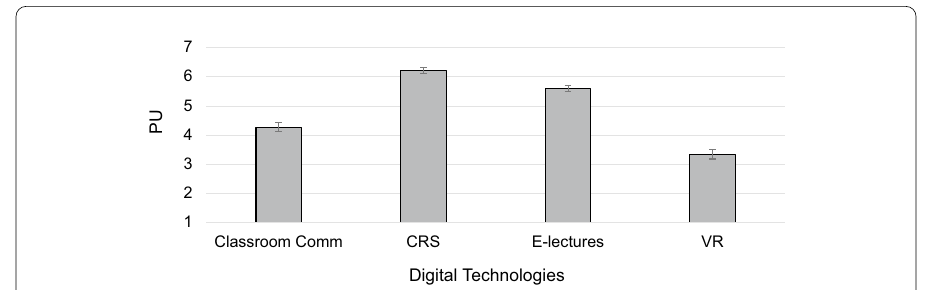
Fig. 5 Perceived usefulness for the CC, CRS, e-lectures, and VR after three months of use. The error bars represent the standard errors of the mean